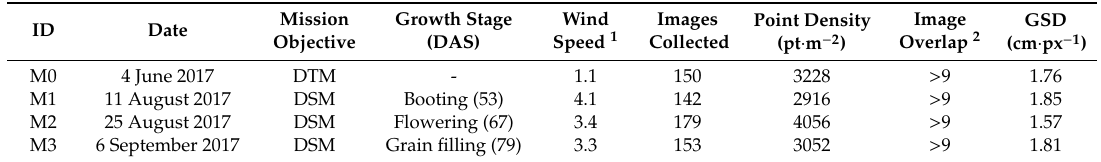
Table 1. Flight mission details. ID = mission number; DTM = digital terrain model; DSM = digital surface model; DAS = days after sowing; GSD = ground sample